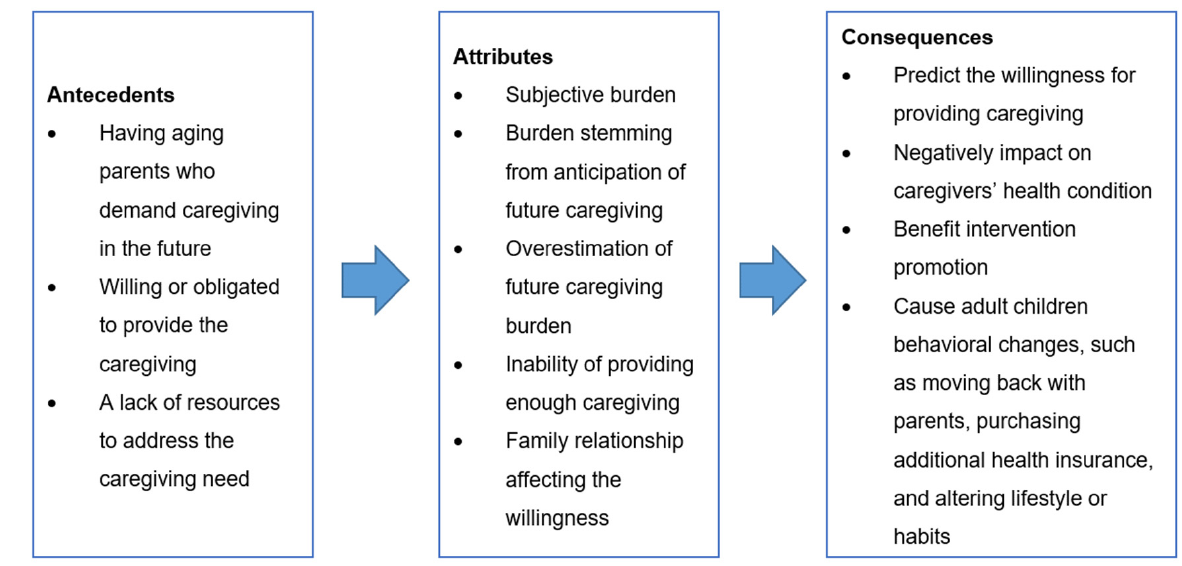
Figure 2. Concept diagram of “anticipatory burden in adult-child caregivers”.